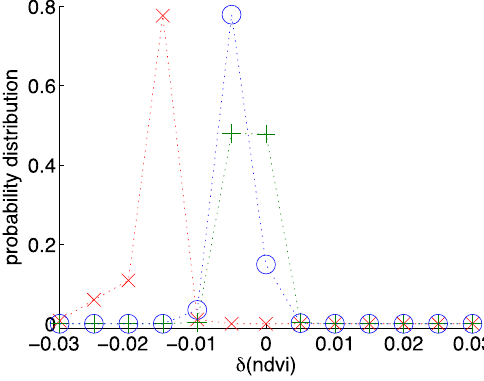
Figure A4. Simulations of NOAA-14 NDVI from the actual count measurements of NOAA-18 AVHRR/3. A negative bias in the error budget is observed (red X points) that is